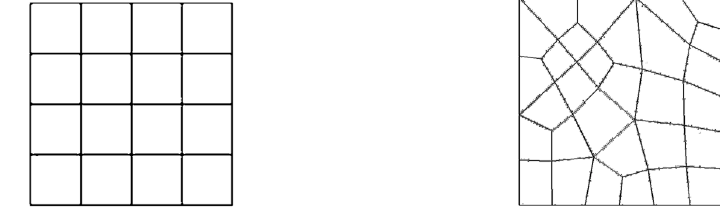
Figure 2. Regular and irregular quadrilateral meshing schemes. Table 1. Error properties results for LS- and RPI (MQ)-based recovery approach in incompressible- elastic plate analysis considering influence zones and conventional patches (four-node quadrilateral regular mesh).